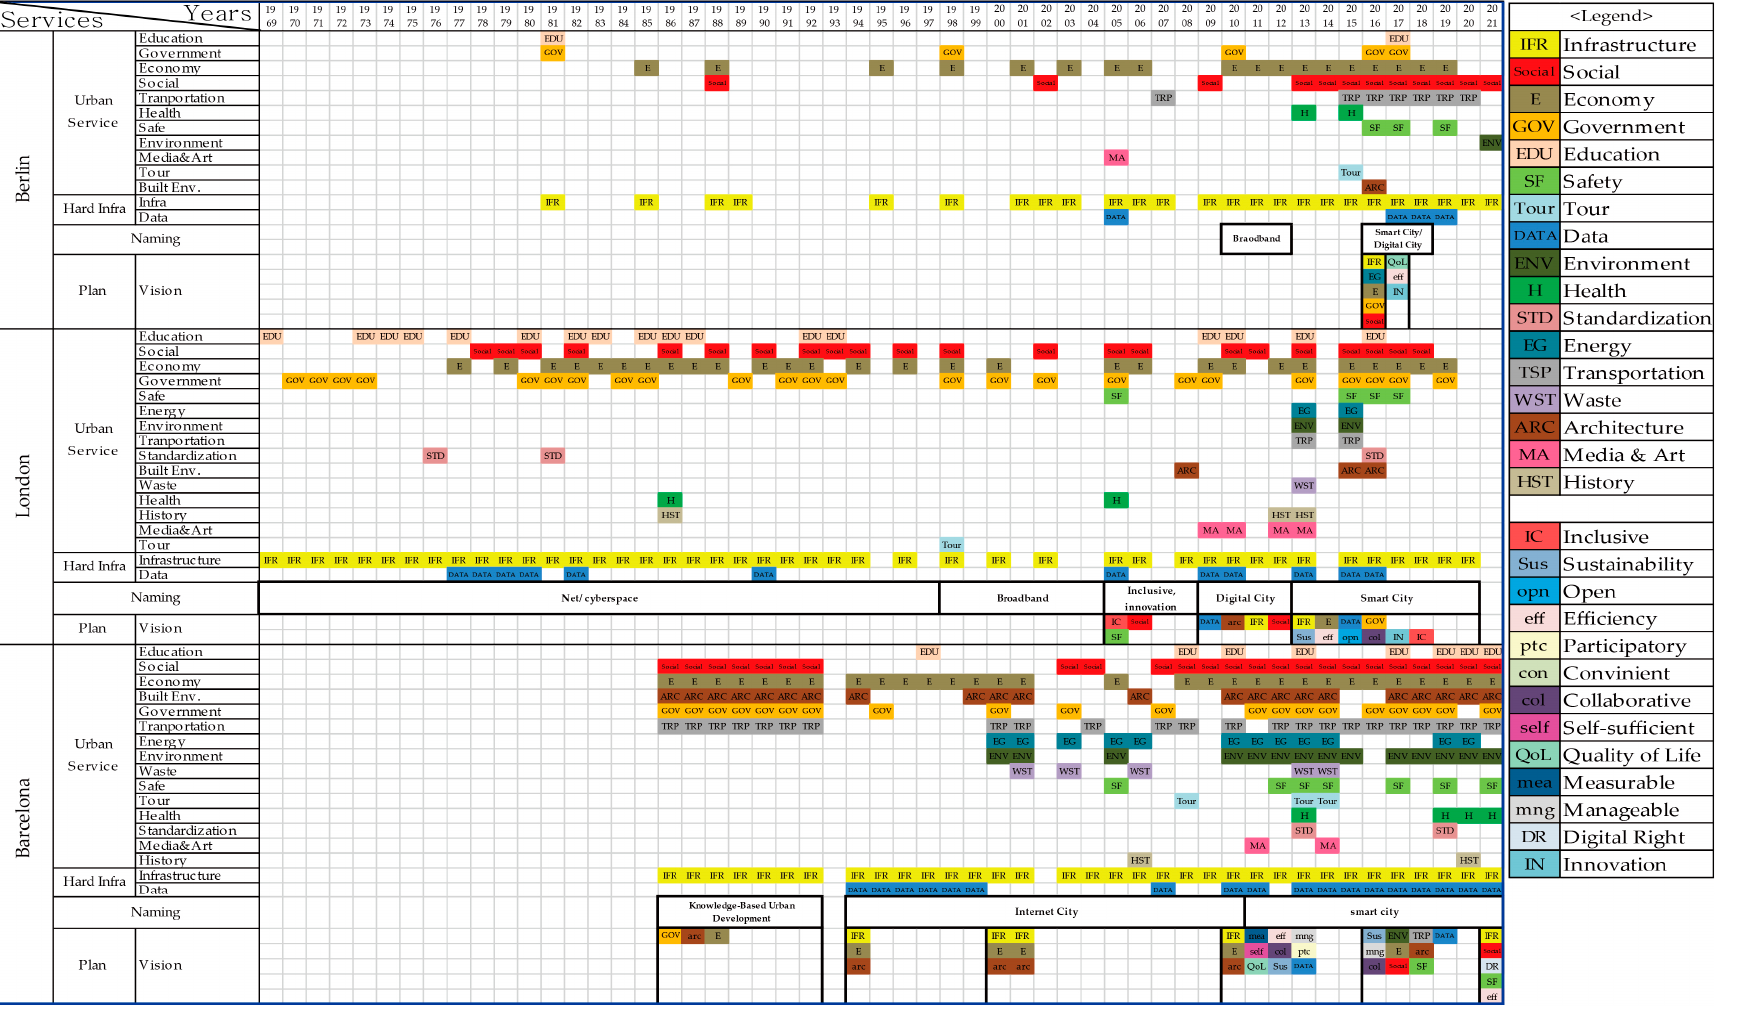
Figure 7. Periodic Matrix Taxonomy of Three European Smart Cities.